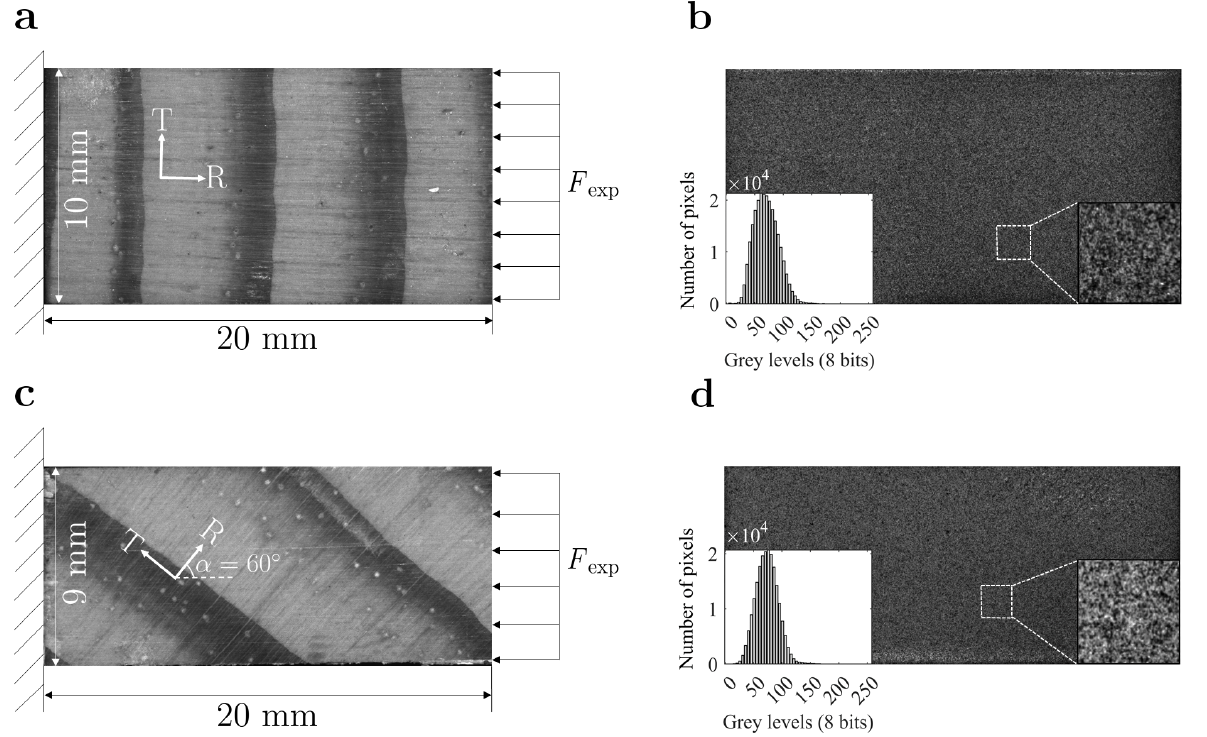
Figure 2. Experimental setup regarding: ( a ) Experimental boundary conditions on on-axis specimen; ( b ) Speckle pattern detail and gray level frequency histogram for one on-axis specimen; ( c ) Experi- mental boundary conditions on off-axis specimen; ( d ) Speckle pattern detail and gray level frequency histogram for one off-axis